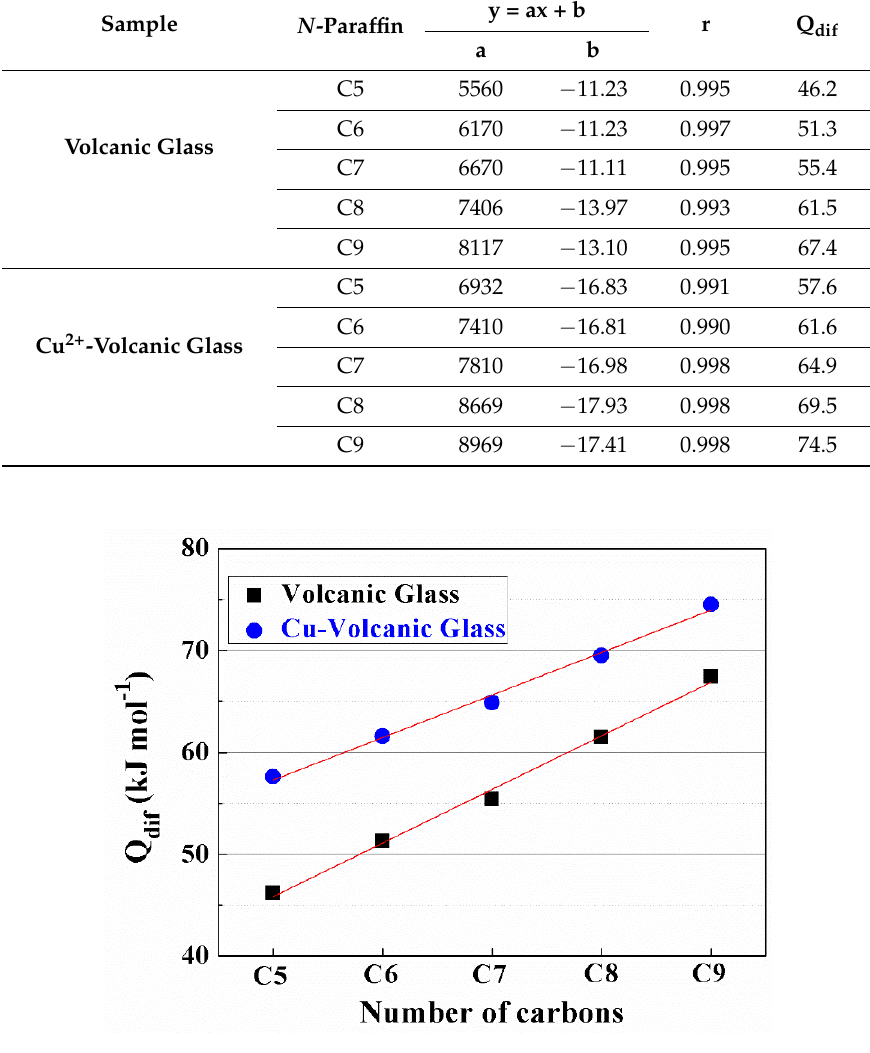
Figure 7. Representation of Q dif vs. carbon number of the paraffin (C 5 –C 9 ).